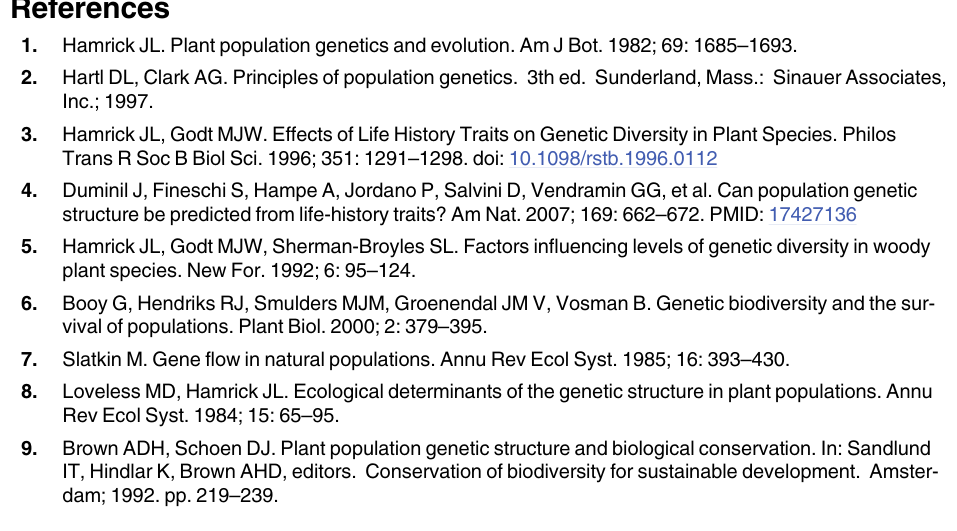
S1 Fig. Dendrogram (BIONJ method, Gascuel, 1997) showing the relatedness among the studied populations of S . thurberi using the Rousset ’ s genetic distances Fst/(1-Fst). At each node is the value of bootstrap (based in 1000 replicates) that supports it. S1 Table. Rousset ’ s genetic distances Fst/(1-Fst) (above diagonal), and geographic distances in km (lower diagonal) among the eight populations studied of Stenocereus thurberi . S2 Table. Analysis of molecular variance (AMOVA) showing the partitioning of genetic variation within and among groups of Stenocereus thurberi defined for STRUCTURE. S3 Table. Estimates of genetic diversity at the species and population level in 23 species of columnar cacti reported until